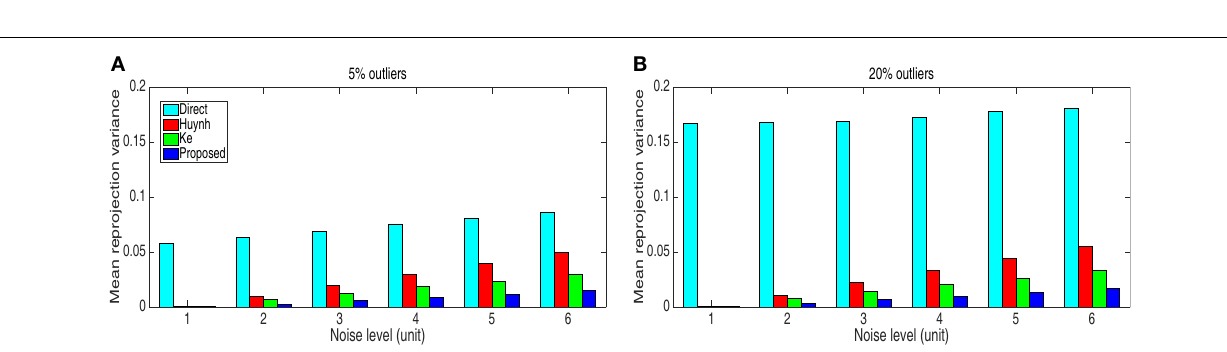
variance at different noise levels and outliers ratios is shown in Figure 4